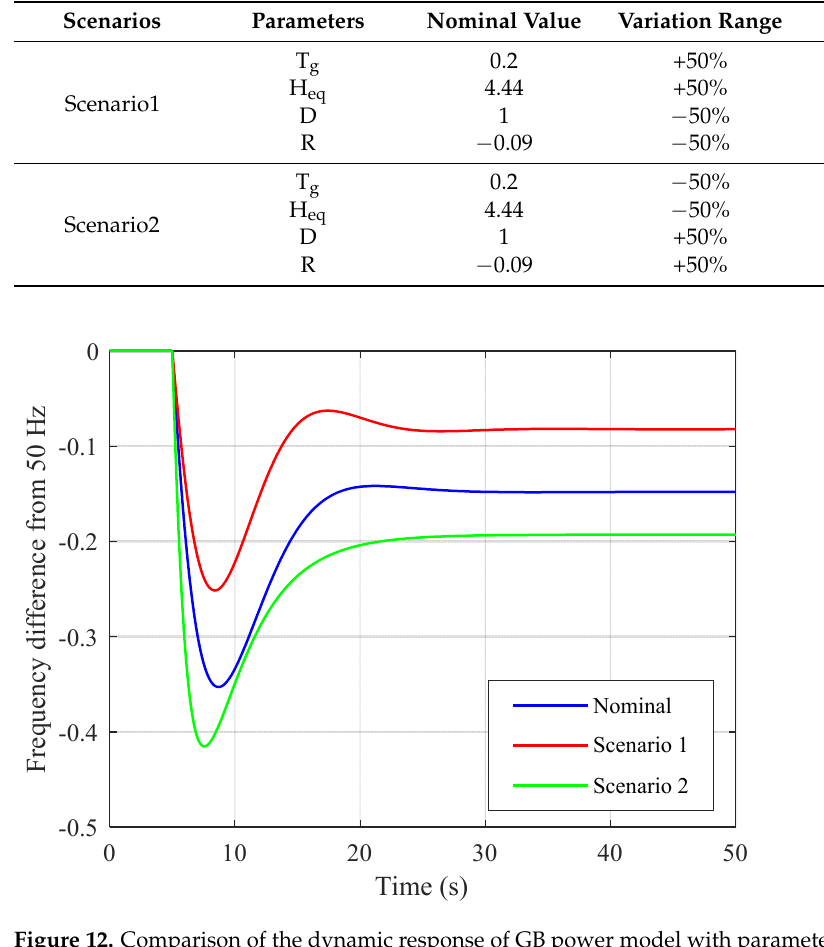
Figure 12. Comparison of the dynamic response of GB power model with parameter uncertainties of scenarios 1 and 2 with no secondary control loop.